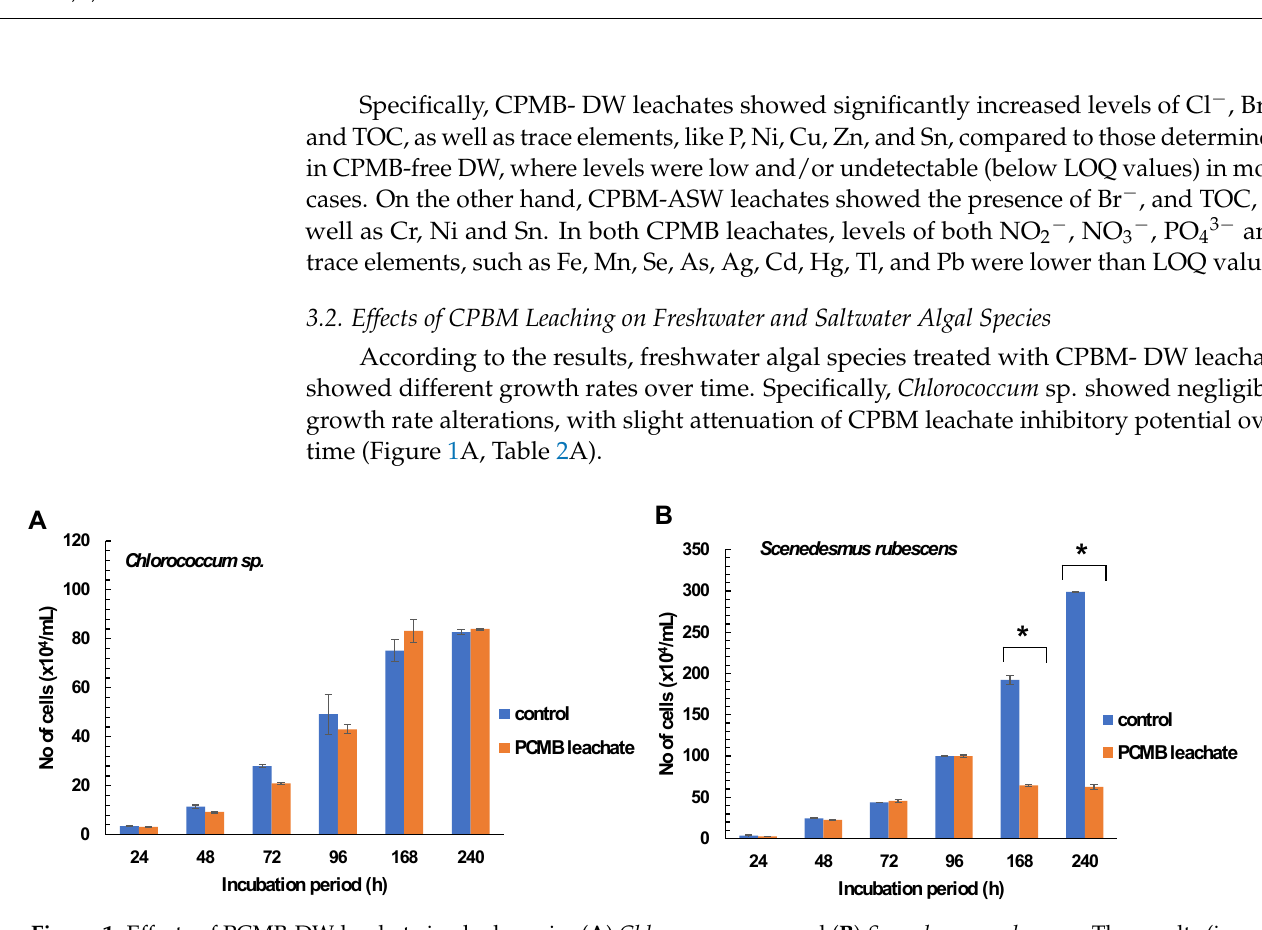
Figure 1. Effects of PCMB-DW leachate in algal species ( A ) Chlorococcum sp. and ( B ) Scenedesmus rubescens . The results (in terms of number of cells × 10 4 mL − 1 ) are mean ± SDs from 4 independent experiments. Asterisks (*) indicate significant difference between control and e-waste treated algae (Mann–Whitney u-test, p < 0.05).